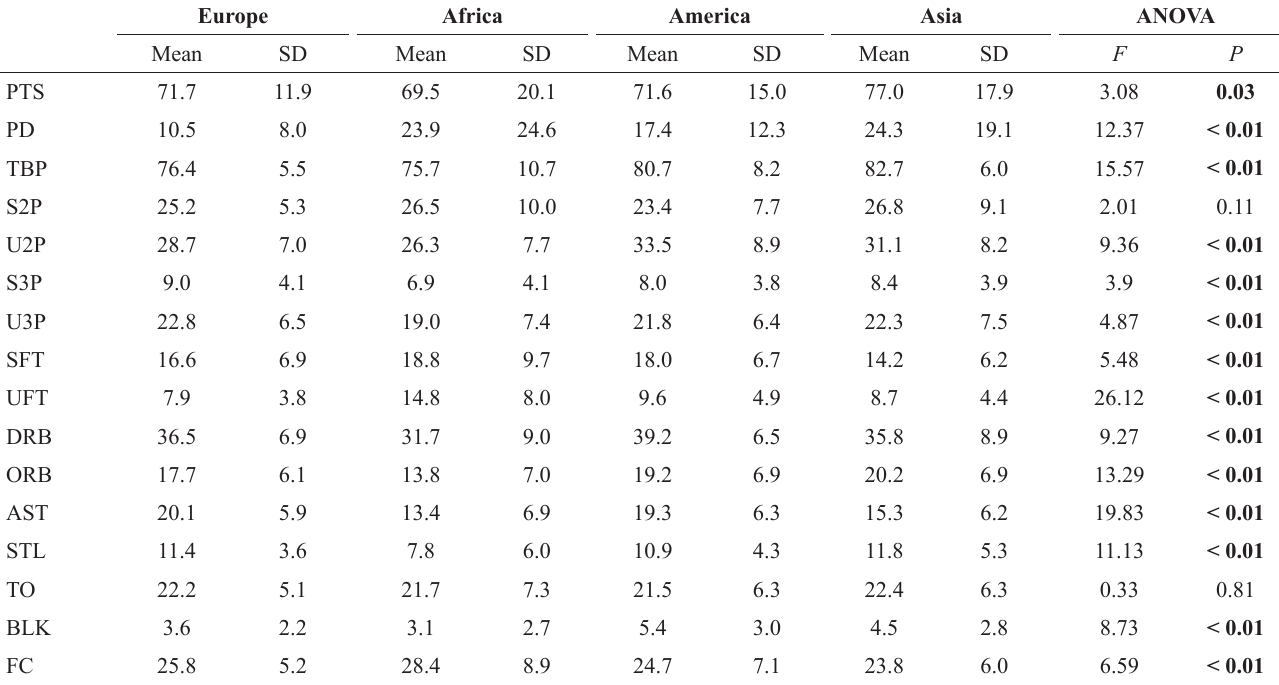
Table 2. Game-related statistics of each continental championship for U18 men. Europe Africa